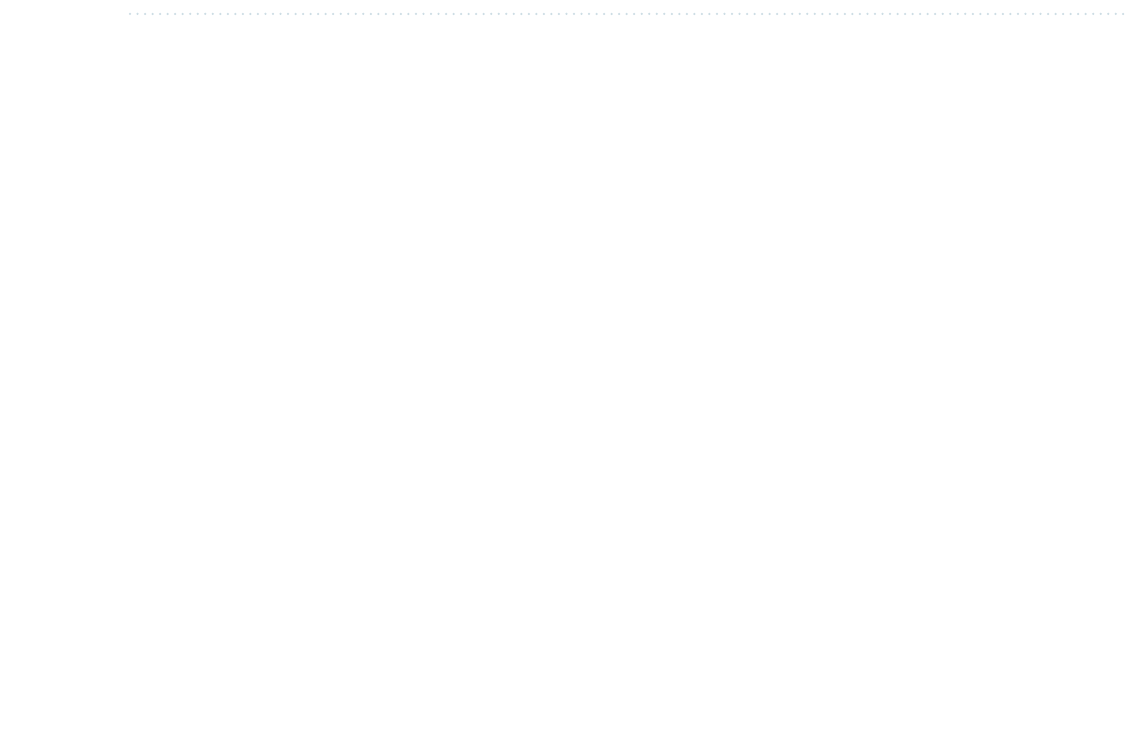
Figure 4. Shows the effects of ℓ 3 on the gained solutions